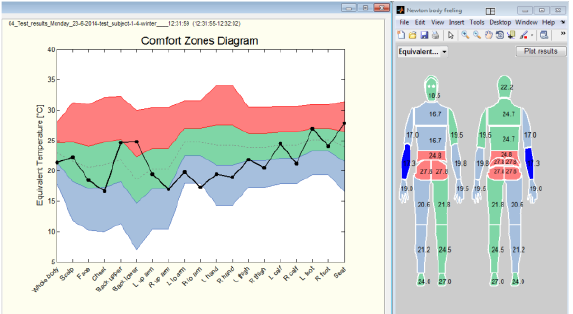
Fig. 8. Comfort zone diagram for winter; corresponding to the conditions of test subject N. 2 after 30 min.